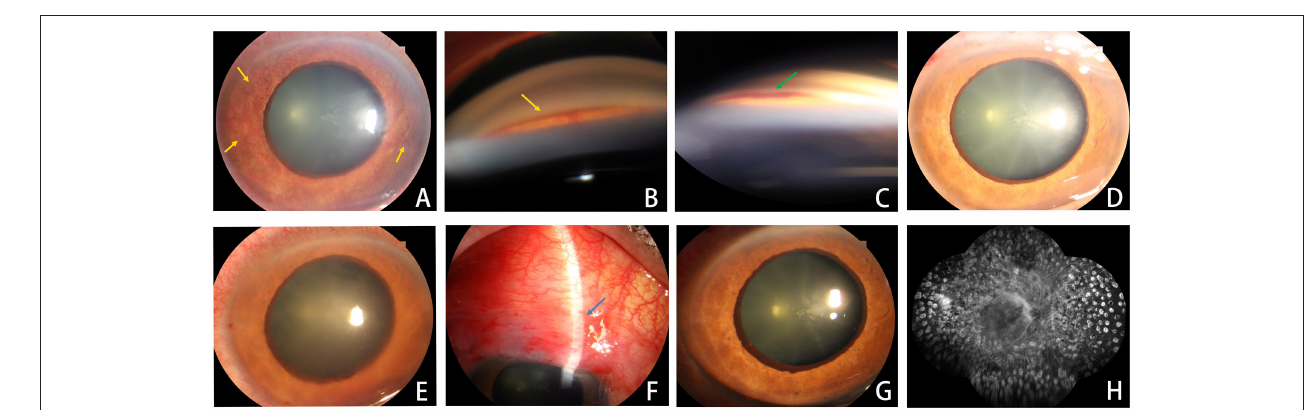
FIGURE 3 | Ophthalmic examination of a typical case. (A–C) Before treatment, yellow arrows indicate NVI and NVA, a green arrow indicates bleeding at the angle; (D) 1 day after conbercept injection; (E) 2 days after conbercept injection; (F) 3 days after trabeculectomy with mitomycin C, blue arrow indicates filtering bleb; (G) 6 months after conbercept injection; (H) the completion of extra-PRP. PRP, Pan-retinal photocoagulation; NVI, neovascularization of Iris; NVA, neo-vessel at the anterior chamber angle.